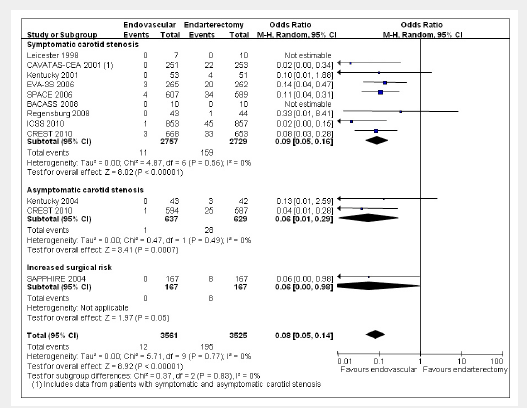
Meta-analysis of randomised trials comparing endovascular treatment with endarterectomy for symptomatic or asymptomatic carotid stenosis: cranial nerve palsy between randomisation and 30 days after treatment. Data are numbers of patients with events, total numbers of patients and Mantel-Haenszel random-effects odds ratios including 95% confidence intervals (CI) with endarterectomy as the reference treatment. Squares on the right represent point estimates of odds ratios at trial level, with 95% CI as horizontal bars. The diamond at the bottom represents the summary OR and 95% CI. Data from the following trials